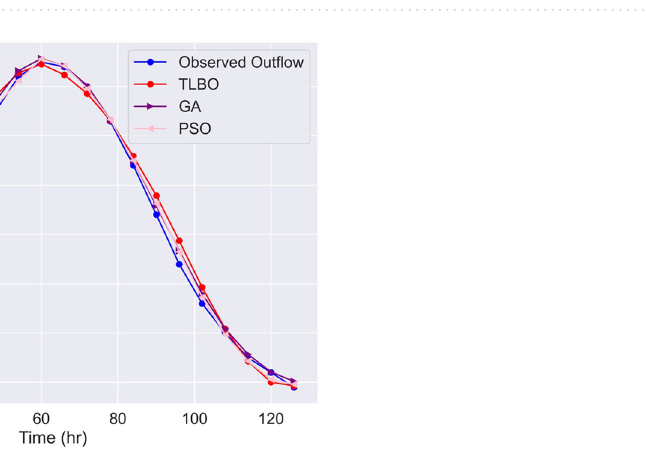
Figure 5. The scatter plots of the observed and simulated outflows corresponding to ( a ) the Wilson, and ( b ) the Wye River benchmarks.